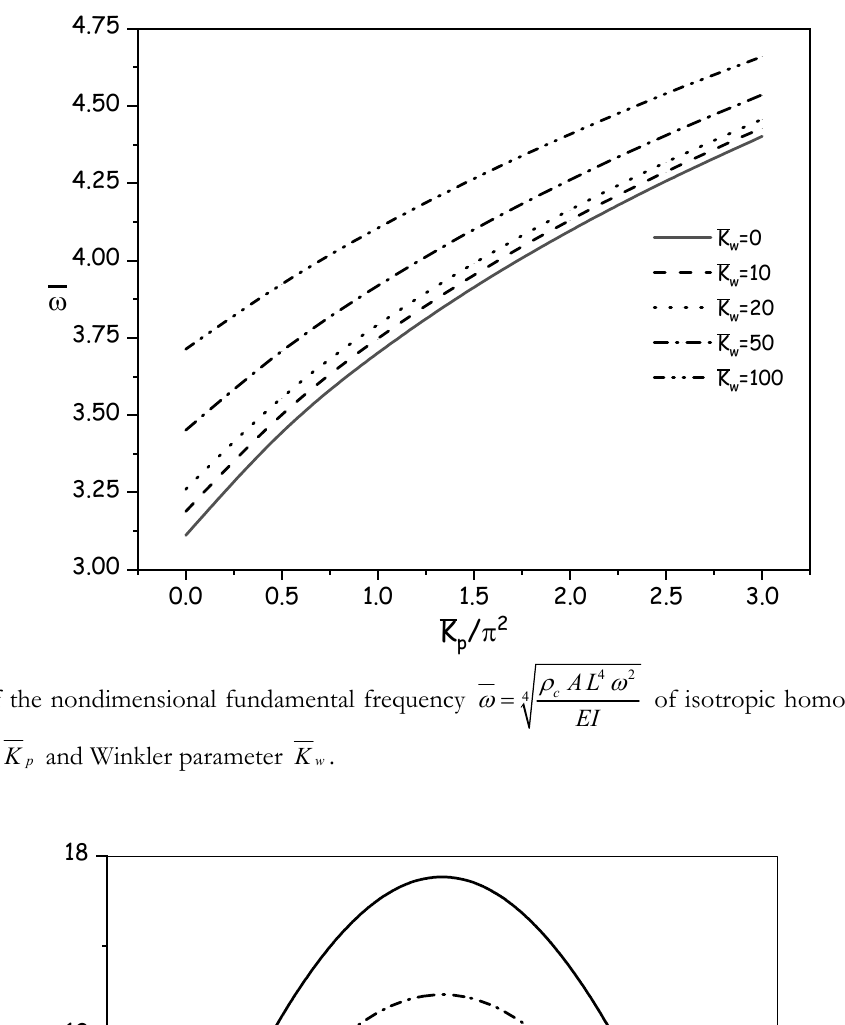
  of isotropic homogeneous beam with